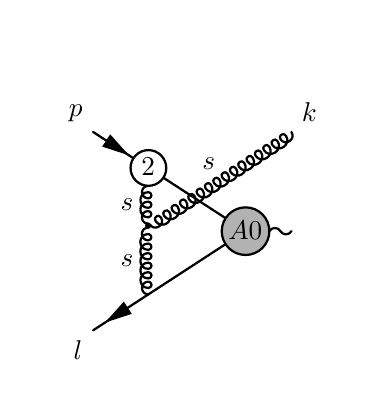
Figure 9 . Collinear one-loop diagrams with one soft gluon emission. The currents A 1 and B 1 de(cid:12)ned in (3.18) and (3.19), respectively, are used here. The collinear virtual gluon must attach to the B 1 current, because of the additional subleading current.